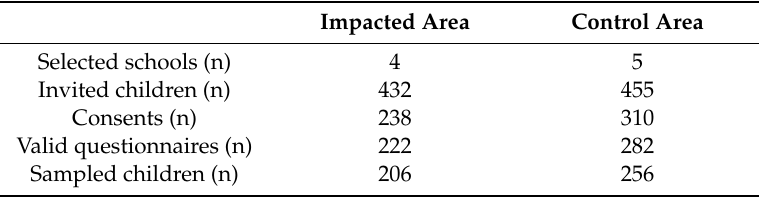
Table 1. Results of recruitment and questionnaire administration